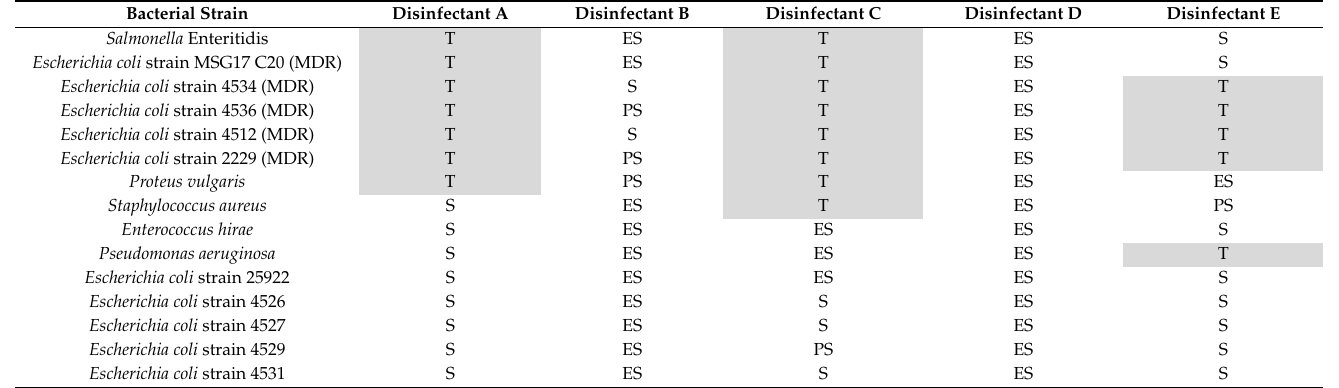
Table 3. Tolerance profiles of the bacterial strains against